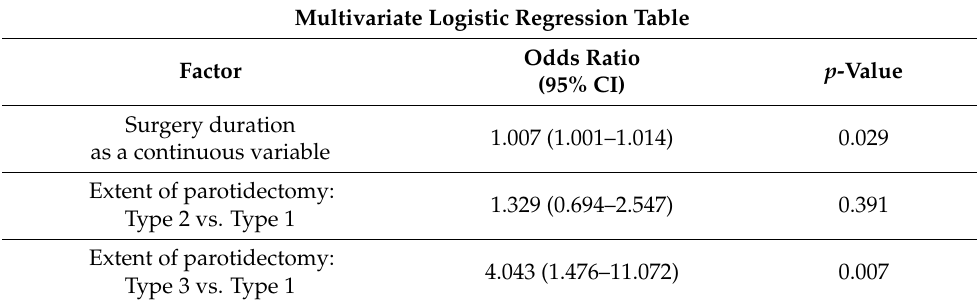
Table 6. Multivariate logistic regression for local perioperative complications after parotidectomy (surgical procedures: n =